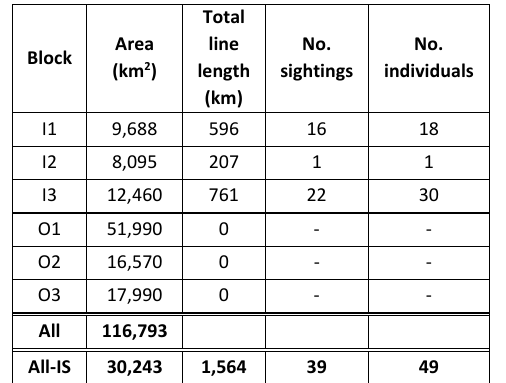
Table 3. Surface area of blocks, realised effort, and overview of harbour porpoise sightings during the 2010 Faroese aerial survey. Only effort in good or moderate porpoise sighting conditions is shown. All-IS refers to inshore strata.